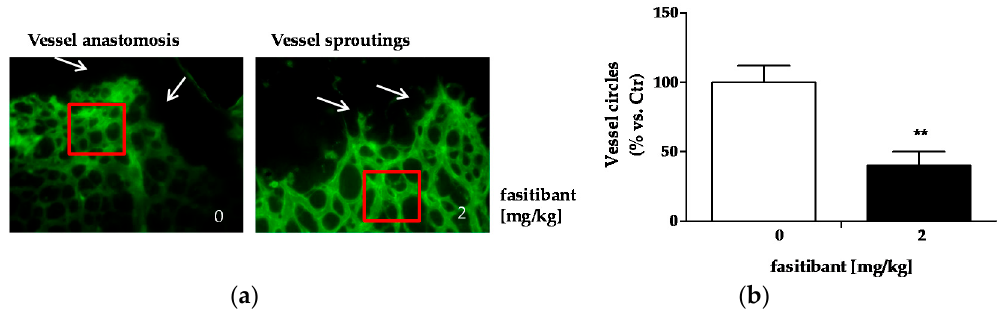
Figure 2. Fasitibant delays retinal vessel maturation in mouse pups. ( a ) Retinas dissected from pups at P8, treated with or without fasitibant (2 mg/kg) were stained for IB4-488. Arrows indicate vessel anastomosis in left panel (Control condition) and vessel sprouting (right panel, fasitibant treatment). Magnitude 40 × ; ( b ) quantification of vessel density measured as number of vessel circles. For measurement of vascular density, a square close to the retinal edge was performed with Photoshop (Adobe Systems) and the density of vascularization in the square was quantified by ImageJ software, and expressed in relation to the control areas (% vs. Ctr). Data are the mean of 10 squares, obtained from at least five flower-like structures. ** p < 0.01 vs. Ctr.